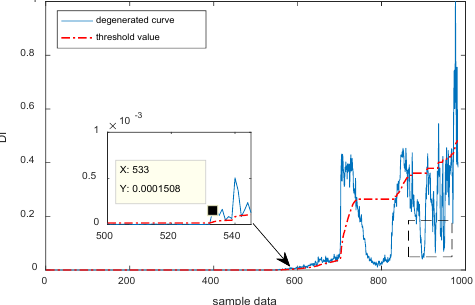
Figure 17. Degradation index based on PCA-SVDD.